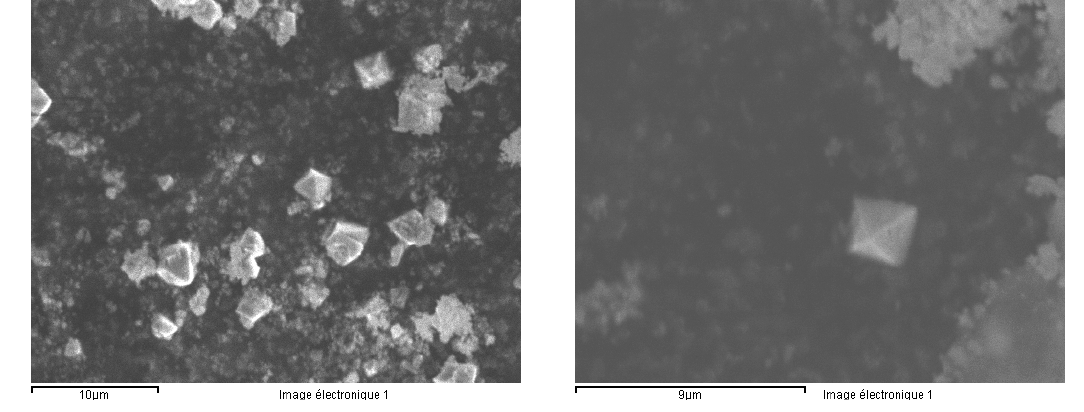
Figure 26. Yttrium fluoride